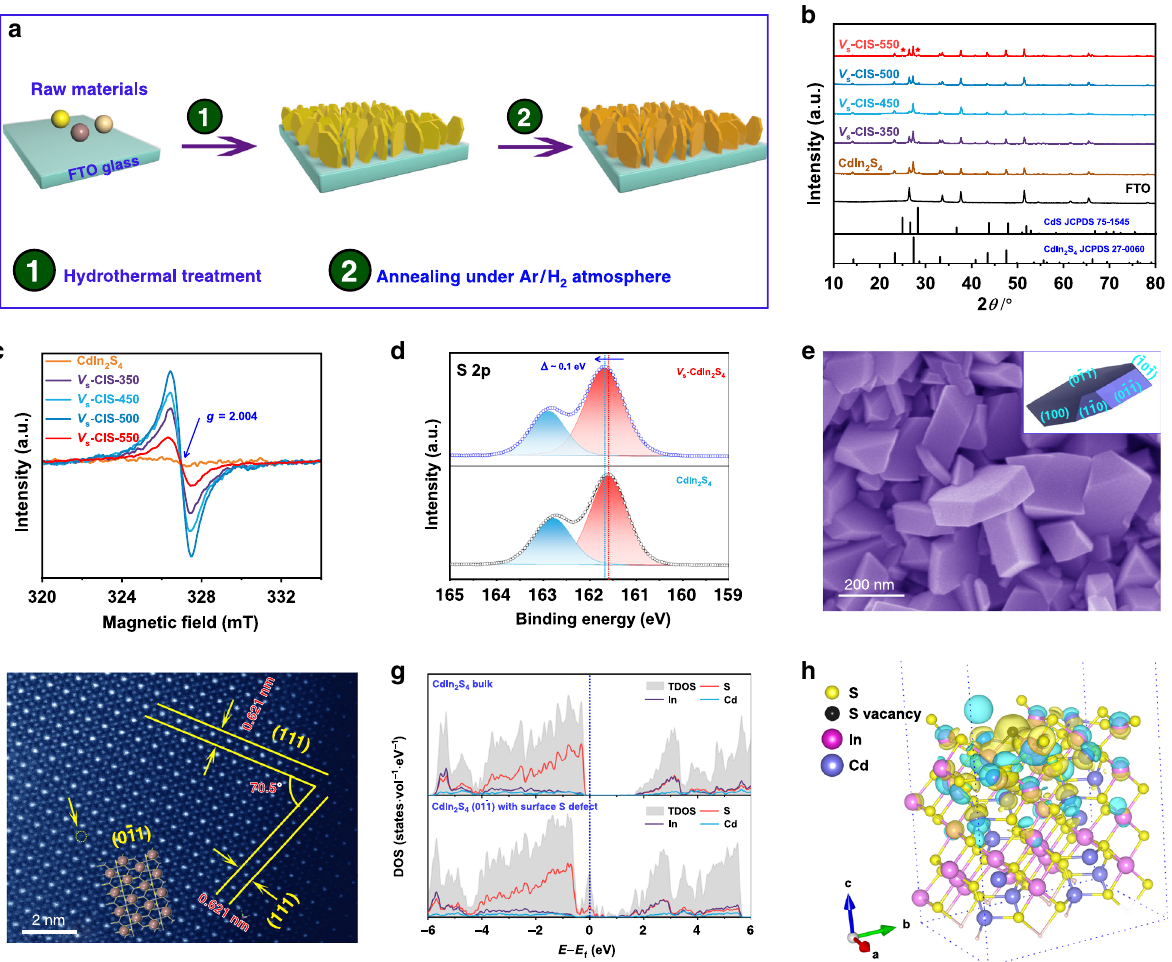
Fig. 1 Synthesis and characterizations of S de fi cient CdIn 2 S 4 nanocrystals. a The schematic diagram for the synthetic procedure of the CdIn 2 S 4 nanocrystals with sulfur vacancies. b PXRD patterns. c ESR spectra. d Core-level XPS spectra of S 2 p for CdIn 2 S 4 and V s -CIS-500. e The SEM image of V s - CIS-500. Inset is the reconstructed shape based on the BFDH theory. f The HADDF-STEM image of V s -CIS-500. Inset is the atomic structure of CdIn 2 S 4 (011) with In and S as truncated atoms. g The density of states for CdIn 2 S 4 bulk and CdIn 2 S 4 (011) with surface sulfur vacancies. h Different charge density image for the CdIn 2 S 4 (011) with surface sulfur vacancies (isosurface set at 0.04e Bohr − 3 ); yellow and cyan regions represent electron accumulation and depletion,